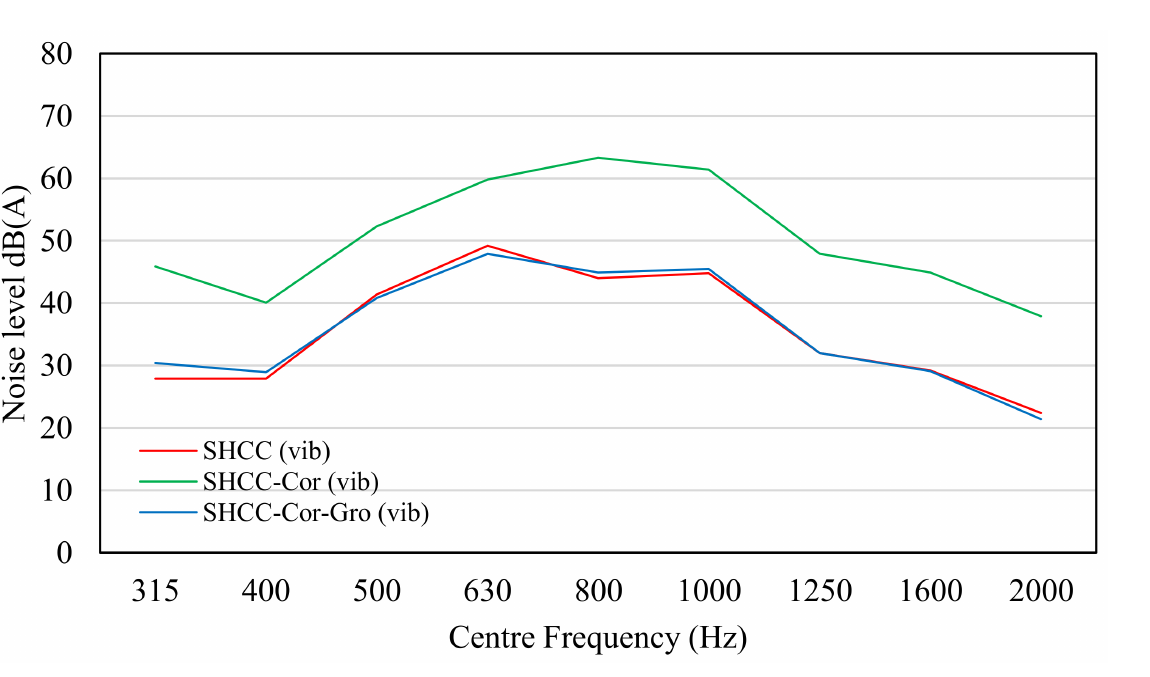
Figure 4. Noise level of SHCC, SHCC-Cor, and SHCC-Cor-Gro based on vibration parameter.